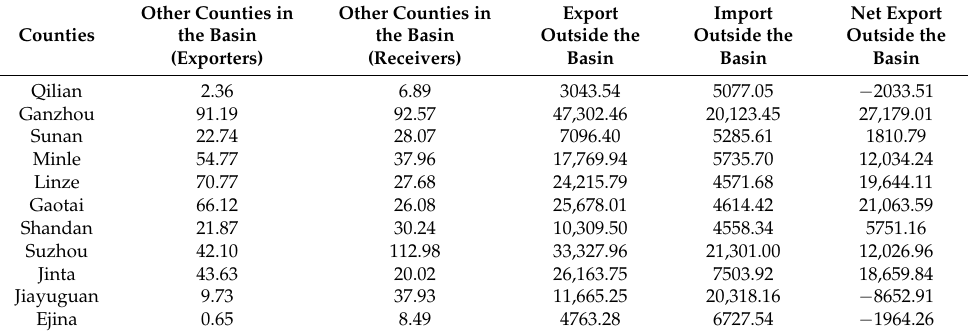
Table 2. An account of the virtual water import and export at county level of the Heihe River Basin (unit: 10 4 m 3